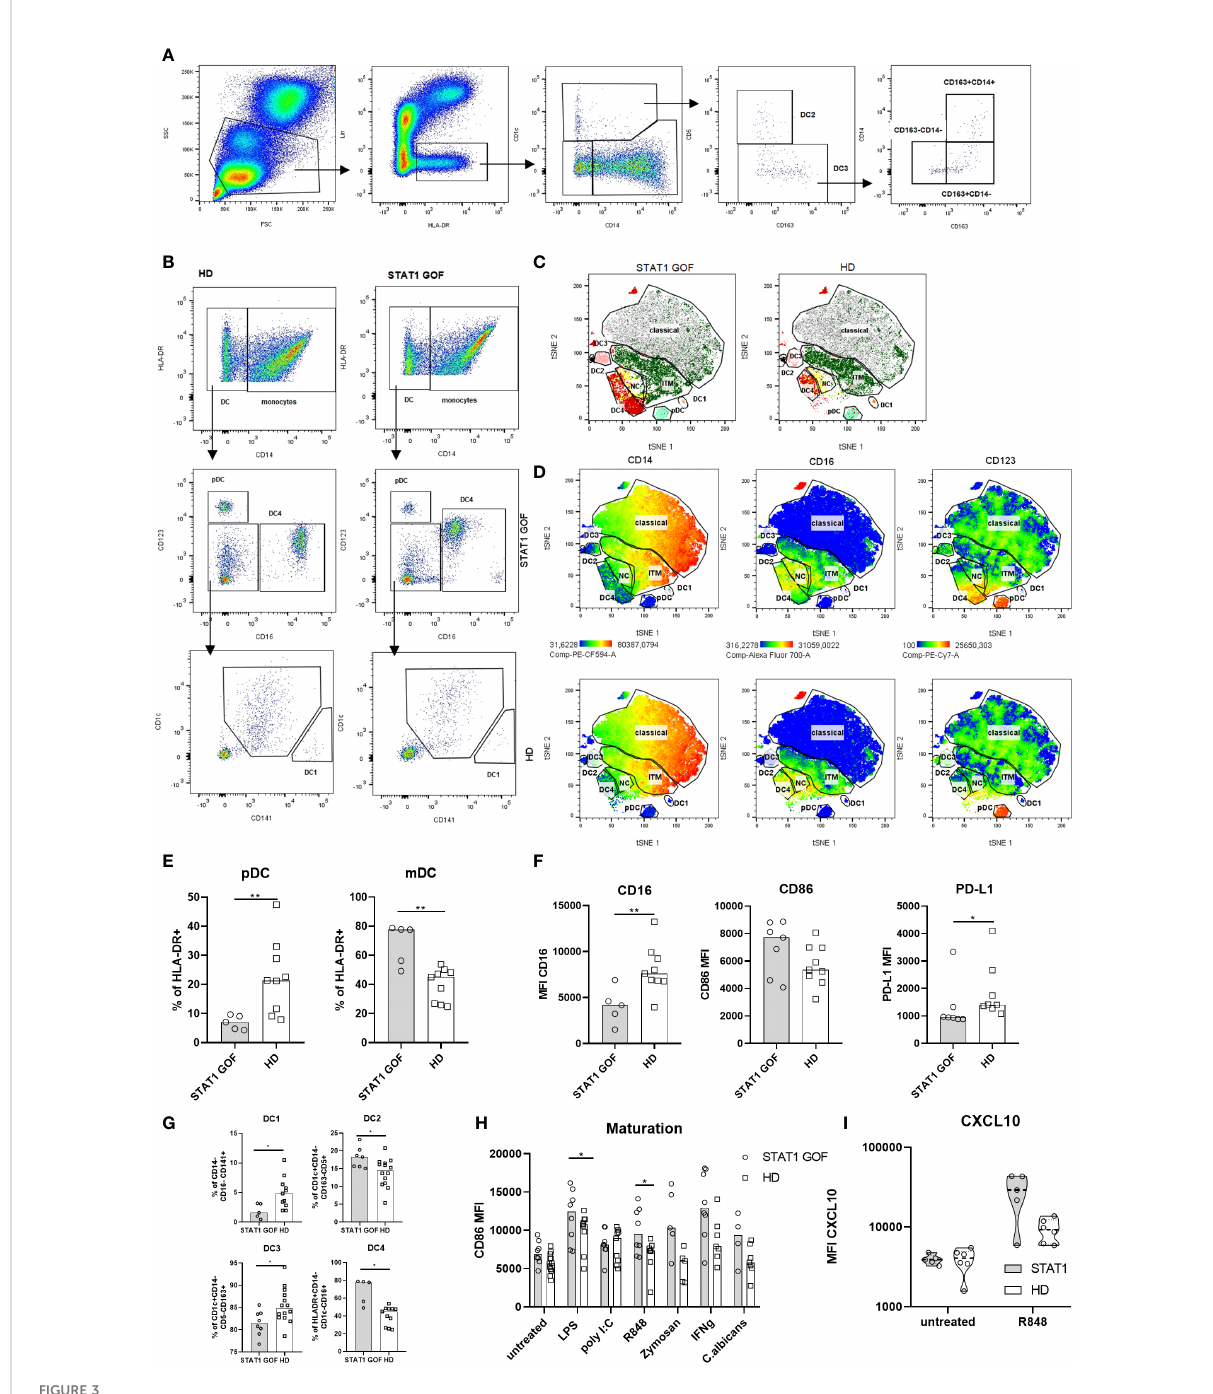
FIGURE 3 Dendritic cells characteristics (A) Gating strategy for DC2 and DC3 subsets analysis (B) Gating strategy forDC1 and DC4 determination (C) Color-coded gating strategy identifying DC subsets in STAT1 GOF patients (n = 5) and HDs (n = 5). The individual subsets are depicted as manually gated populations overlaid onto the tSNE plots (D) Representative tSNE plots of 5 STAT1 GOF and 5 HDs ’ DC showing expression of CD14, D16 and CD123. The DC ’ s subsets are depicted as manually gated populations overlaid onto the tSNE plots (E) pDC and mDC quanti fi cation in STAT1 GOF (n = 7) and HDs (n = 9) detected by fl ow cytometry (F) mDC phenotype of STAT1 GOF (n = 7) and HDs ’ DC (n = 9) detected by fl ow cytometry (G) Quanti fi cation of DCs ’ subsets in STAT1 GOF and HDs detected by fl ow cytometry (H) CD86 expression on mDCs ’ surface upon stimulation with various TLR ligands for 24hours in STAT1 GOF (n = 7) and HDs (n = 9) detected by fl ow cytometry (I) CXCL10 production by mDCs upon R848 (1ug/mL) stimulation in STAT1 GOF (n=7) and HD (n=8) detected by fl ow cytometry DC, dendritic cell; HD, healthy donors; tSNE, t-distributed stochastic neighbor embedding. Values are standardized and expressed as median values. Statistical analyses were performed using paired t-tests. Values of p<0.05 (*), and p<0.0001 (****) were considered statistically signi fi